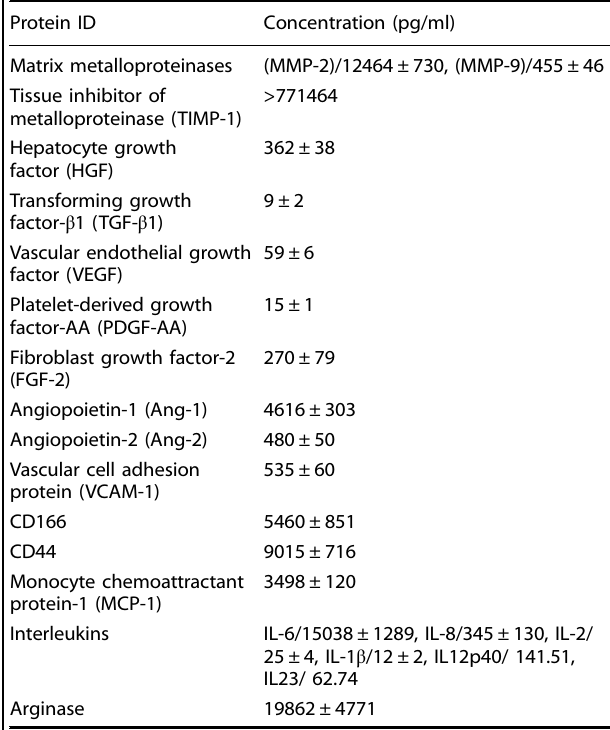
Table 2. hGF protein